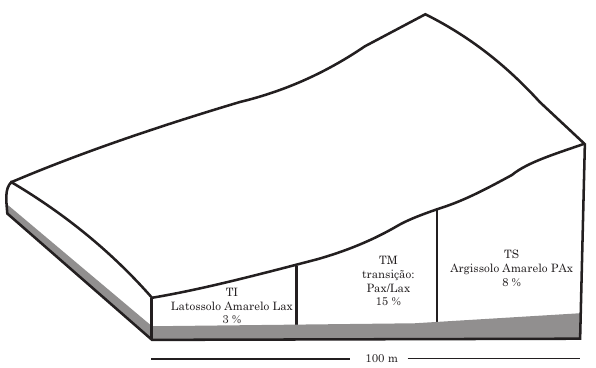
Figura 1. Distribuição dos Argissolos (TS - parte superior) e Latossolos (TI - parte inferior), com suas respectivas declividades, desenvolvidos de sedimentos da Formação Macacu em vertente convexa-divergente no município de Itaboraí, RJ. Os valores percentuais abaixo de cada classe de solo referem-se às declividades médias do terreno em cada segmento da